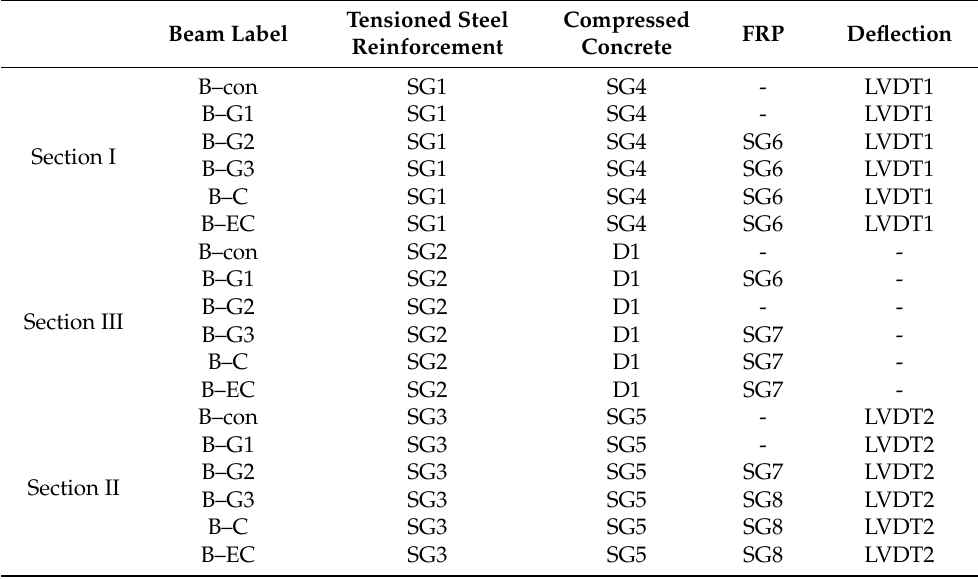
Table 7. Position of strain gauge tapes (SG) and linear variable displacement transducers (LVDT) dilatometers in Sections I, II and III of the tested